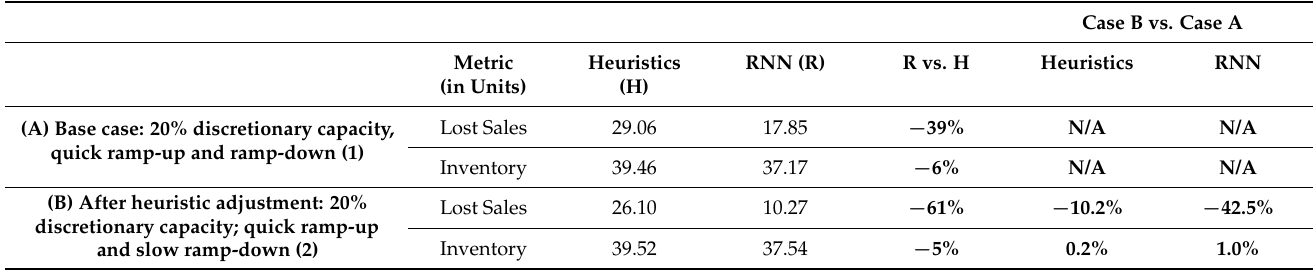
Table 2. Outcome metrics